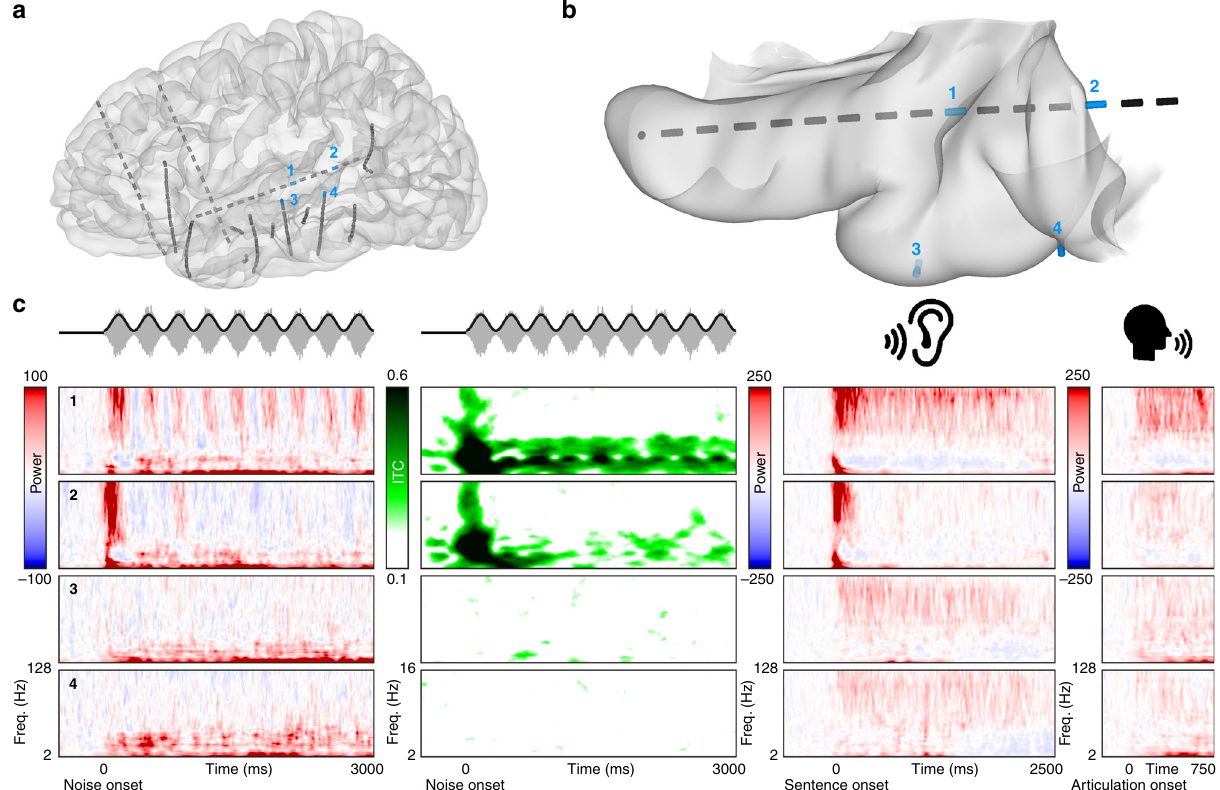
Fig. 2 Cortical response to white noise and natural spoken language. Cortical responses in a single patient to low- and high-level auditory stimuli. a Location of all electrodes implanted in this patient relative to a model of the pial surface. b The supratemporal plane, isolated from the cortical model and viewed from above. All electrodes along the supratemporal depth probe are shown, as well as the two most super fi cial electrodes from probes in lateral superior temporal gyrus. Four electrodes are highlighted in blue with labels. c Neural responses at the four highlighted electrodes: (1) HG/TTS, (2) PT, (3), mediolateral superior temporal gyrus, and (4) posterolateral superior temporal gyrus. The fi rst two columns show the spectral decomposition of the power and phase response, respectively, during white noise listening. The latter two columns show the power response during natural language listening and production,